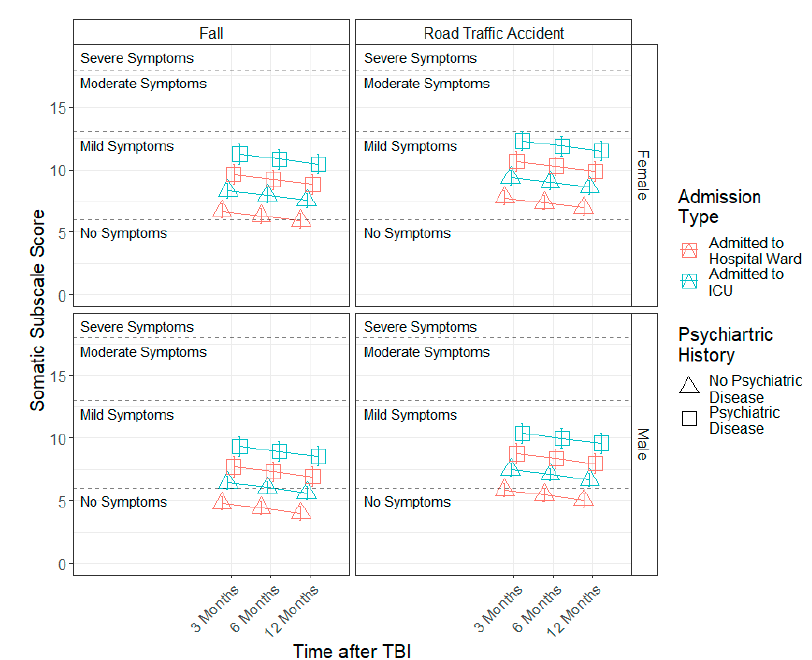
Figure 2. Modelled trajectories for the somatic factor by significant predictors.